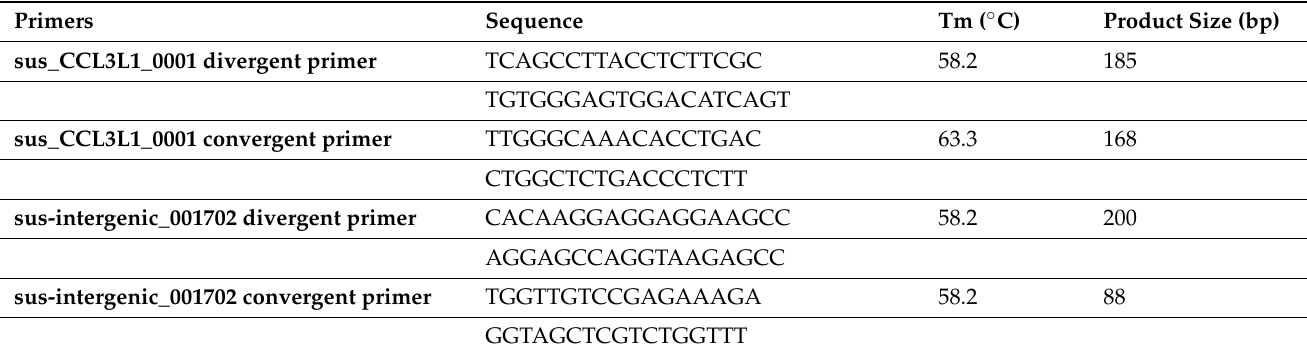
Table 1. Primers used for circRNA